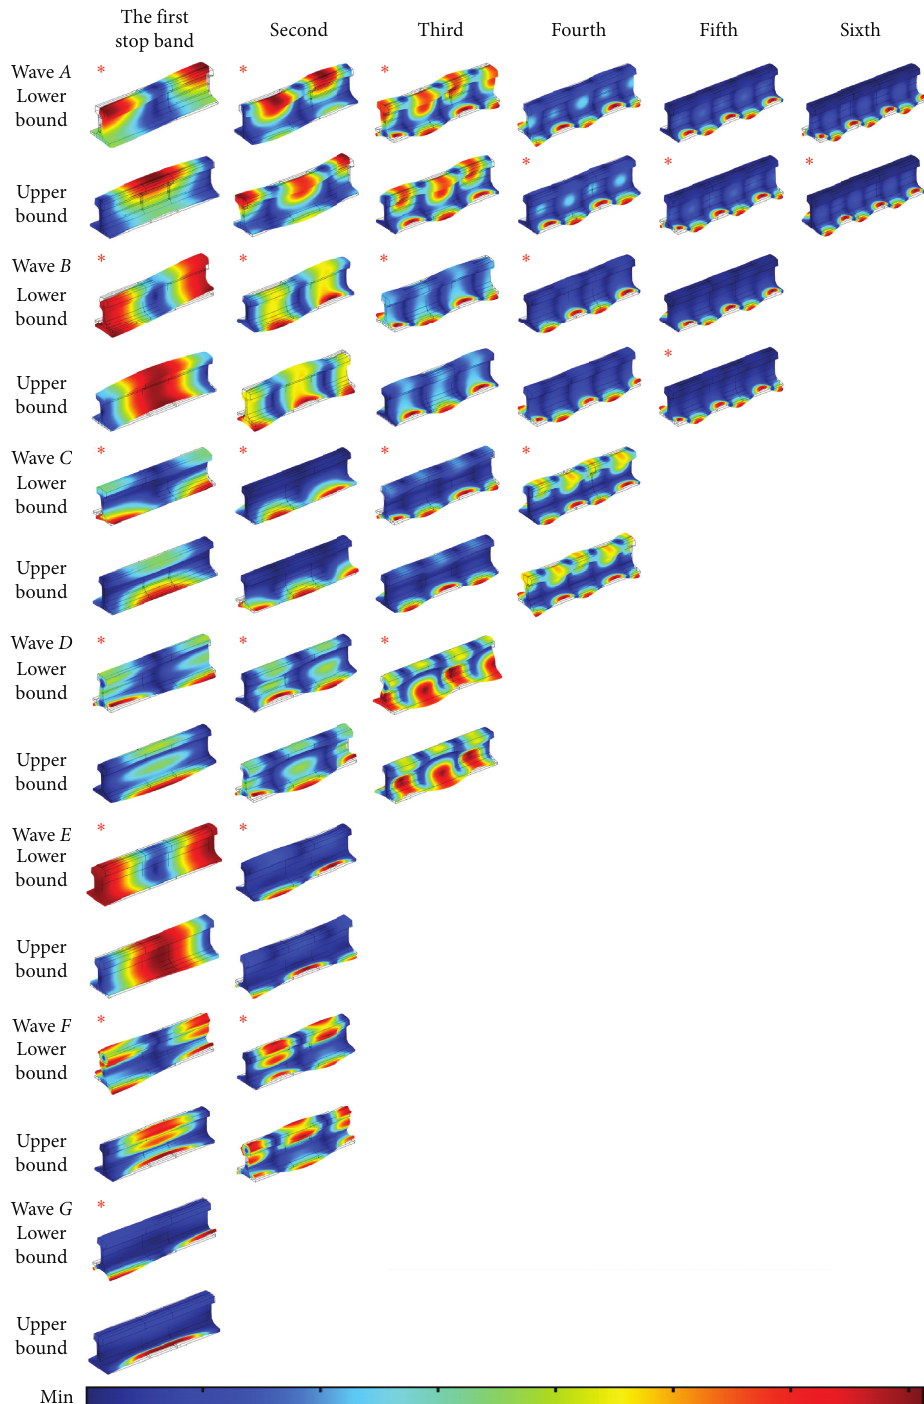
Figure 9: The wave modes at the stop-band bounding frequencies of waves A ∼ G